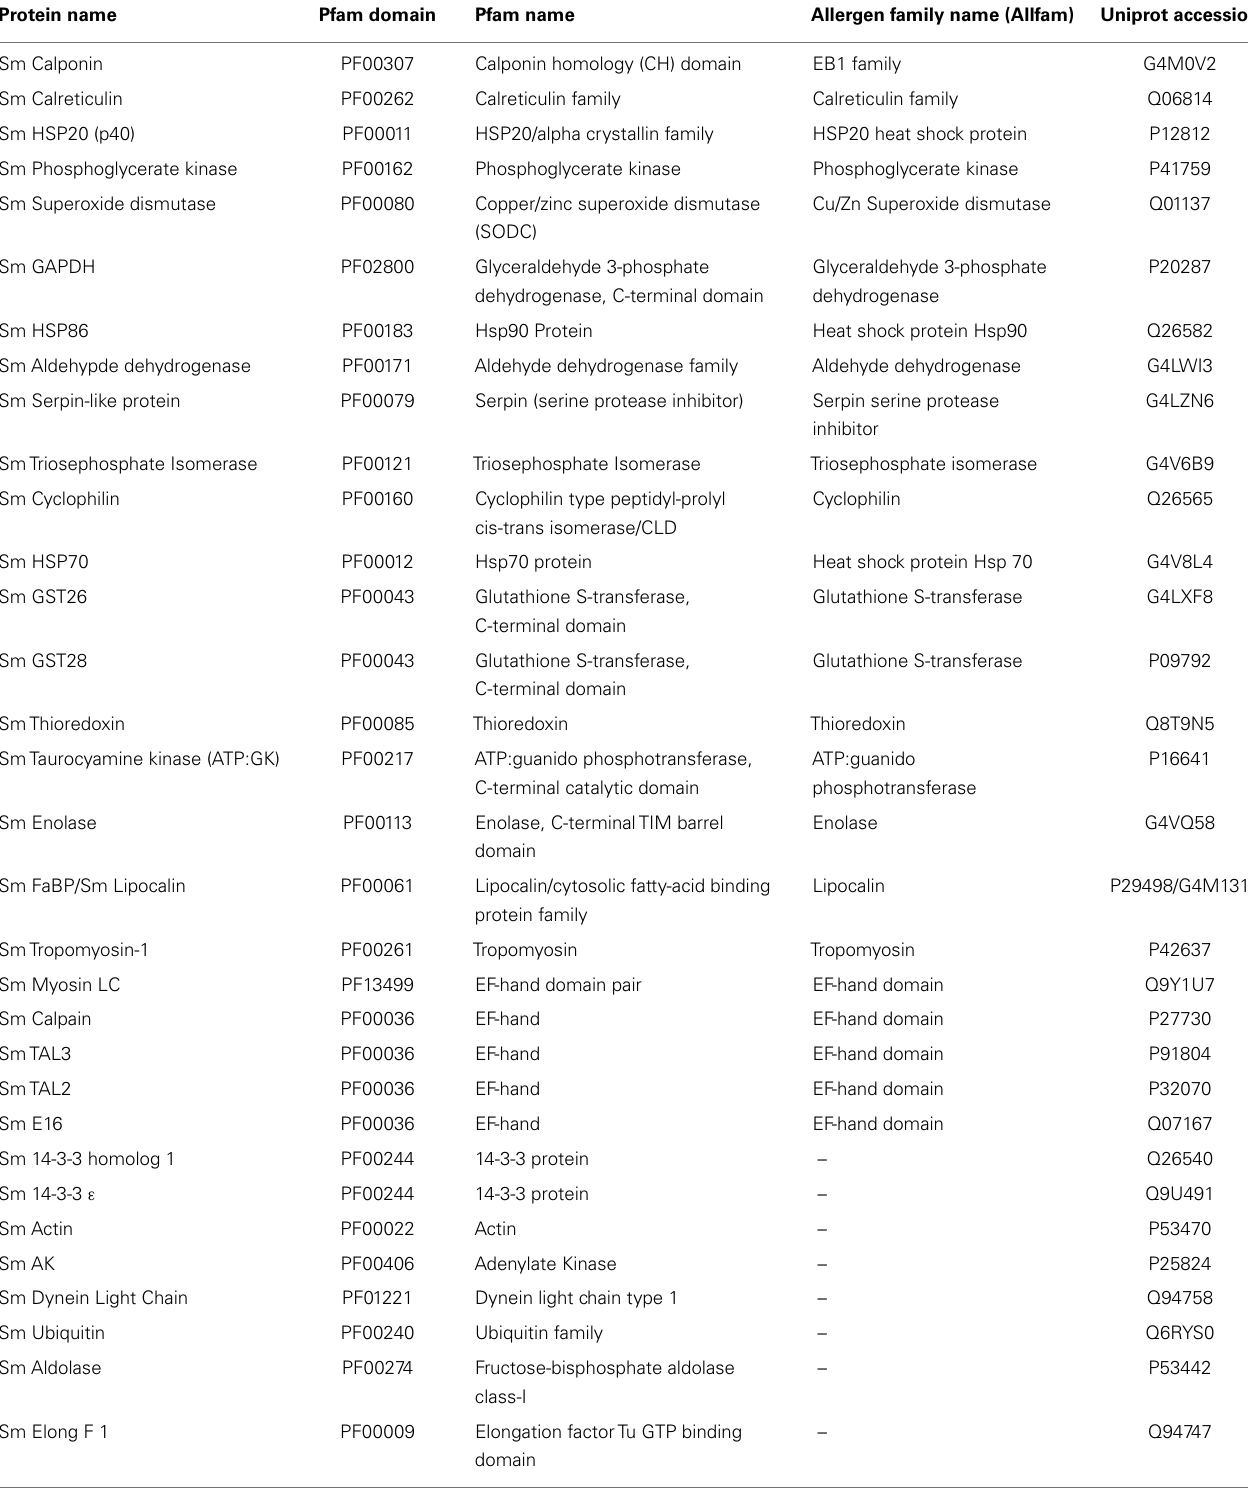
Table 2 | Identification of allergen-like proteins in abundant proteins from S. mansoni as identified in proteomic studies by Curwen et al. (21)